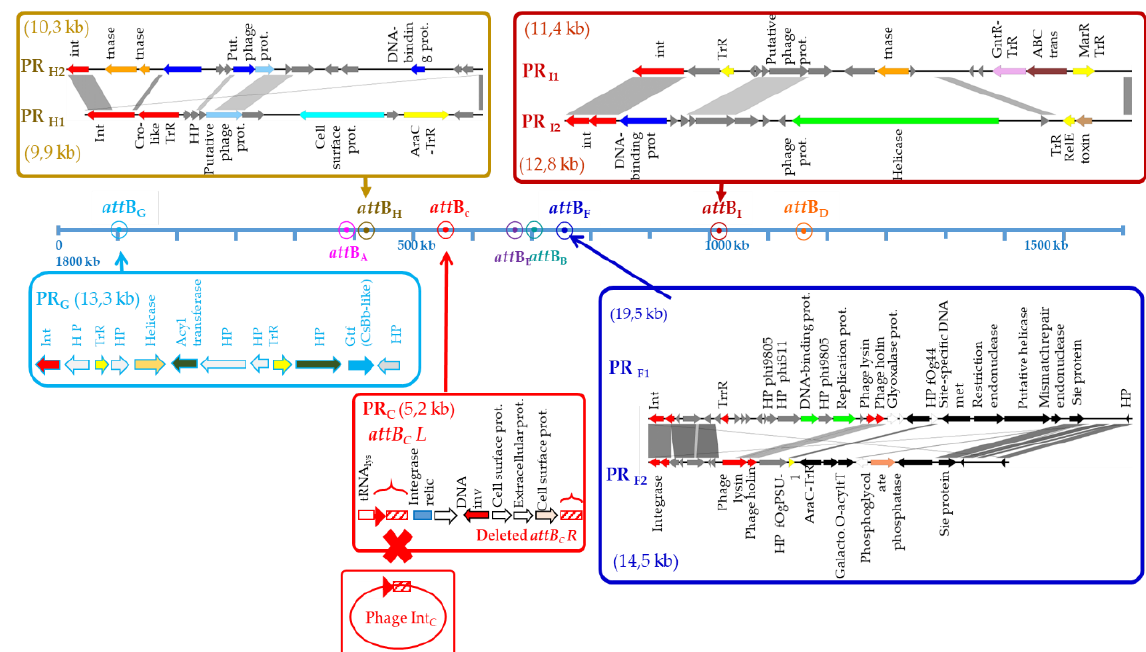
Figure 2. Localization and genetic organization of prophage remnants in the genome of Oenococcus oeni . Genes encoding hypothetical proteins are represented in gray.